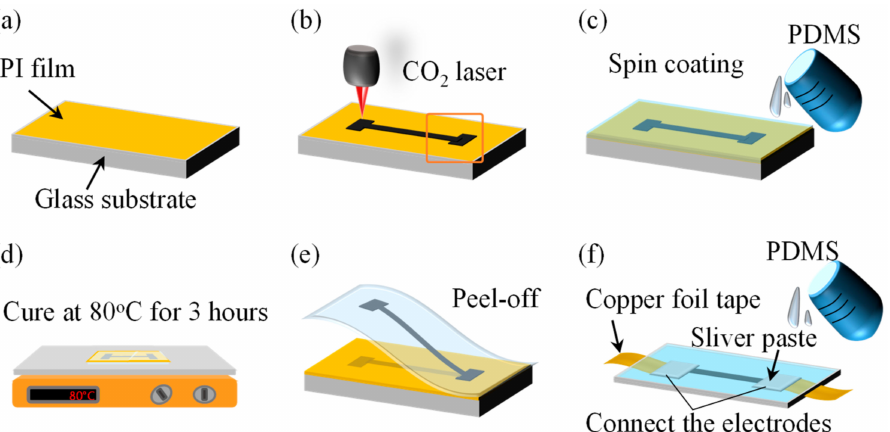
Figure 3. Fabrication process for the stretchable LIG strain sensor. ( a ) PI film was attached to the glass substrate, ( b ) a CO 2 laser was used to scan on PI film, ( c ) PDMS was penetrate to LIG by spin coating, ( d ) PDMS was cured on hot plate, ( e ) PDMS film with an LIG layer was peeled from the PI film, ( f ) LIG strain sensor was prepared by connecting electrodes and PDMS covering process.